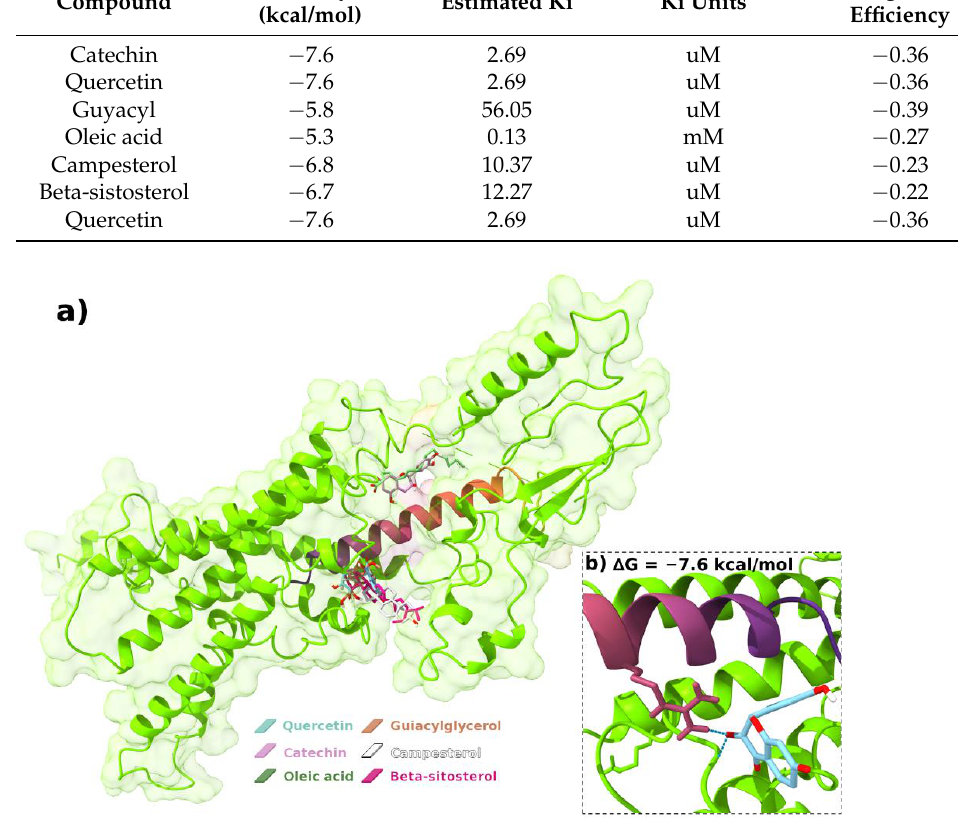
Figure 7. ( a ) Predicted bonded interactions (green dashed lines) between quercetin, catechin, oleic acid, guiacylglycerol, campesterol, and beta-sitosterol interact via H-bonding with PACAP and PAC1; ( b ) binding mode for the catechin and quercetin with the highest interaction for molecular dynamics with the protein.